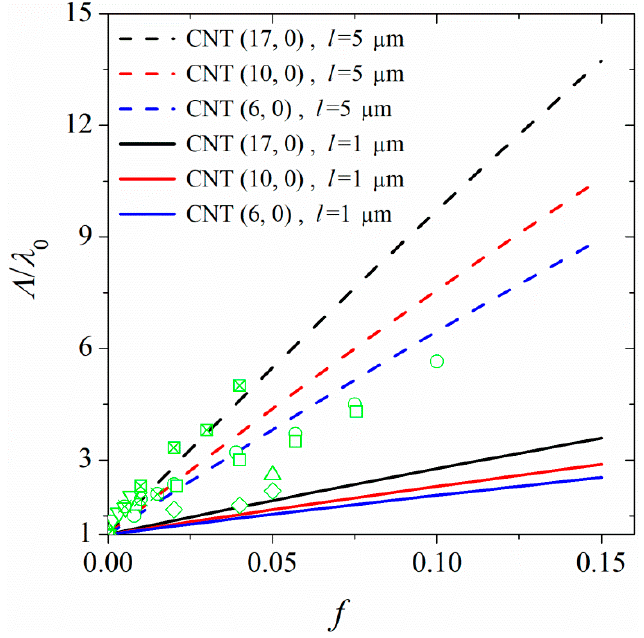
Figure 9. Enhancement in the thermal conductivity of nanocomposite as a function of CNT volume fraction. The full and dashed lines represent the results of EMA modeling for CNTs of length 1 and 5 µ m, respectively. The markers represent experimental data by Yu et al. [36], circles; by Yu et al. [9], (squares); by Patti et al. [37], diamonds; by Liu et al. [38], upward triangles; by Deng et al. [39], downward triangles, by Hong and Tai [40] (crossed squares), and by Song and Youn [41] (crossed circles).